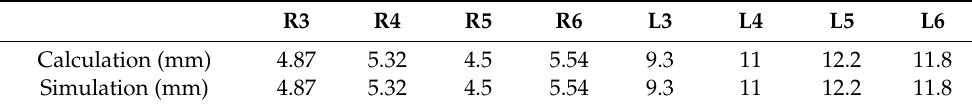
Table 2. The structure size of TE 03 -TE 02 mode